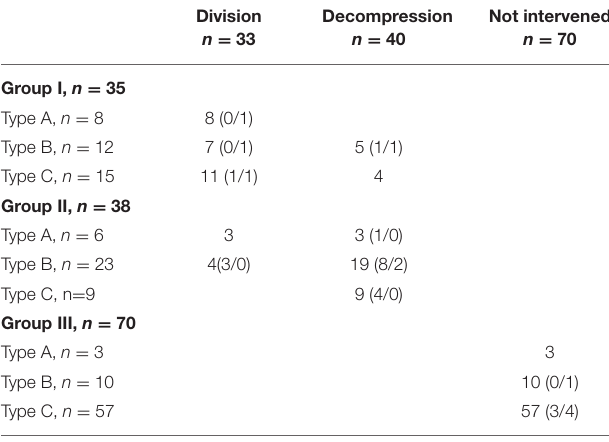
TABLE 3 | Management strategy for VO-VREZ of distinct types and